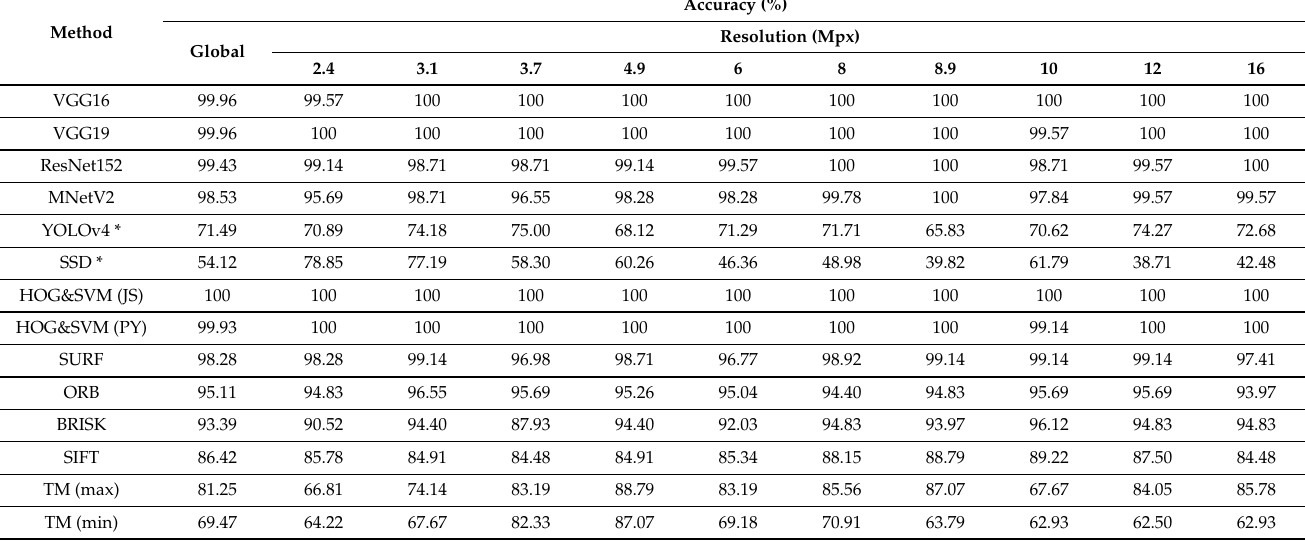
Table 5. Accuracy results of the tests performed on the tactode_small test dataset and their distribution by the available resolutions. The “*” in YOLOv4 and SSD indicates that their accuracy values were computed according to Equation (2). JS, JavaScript; PY,